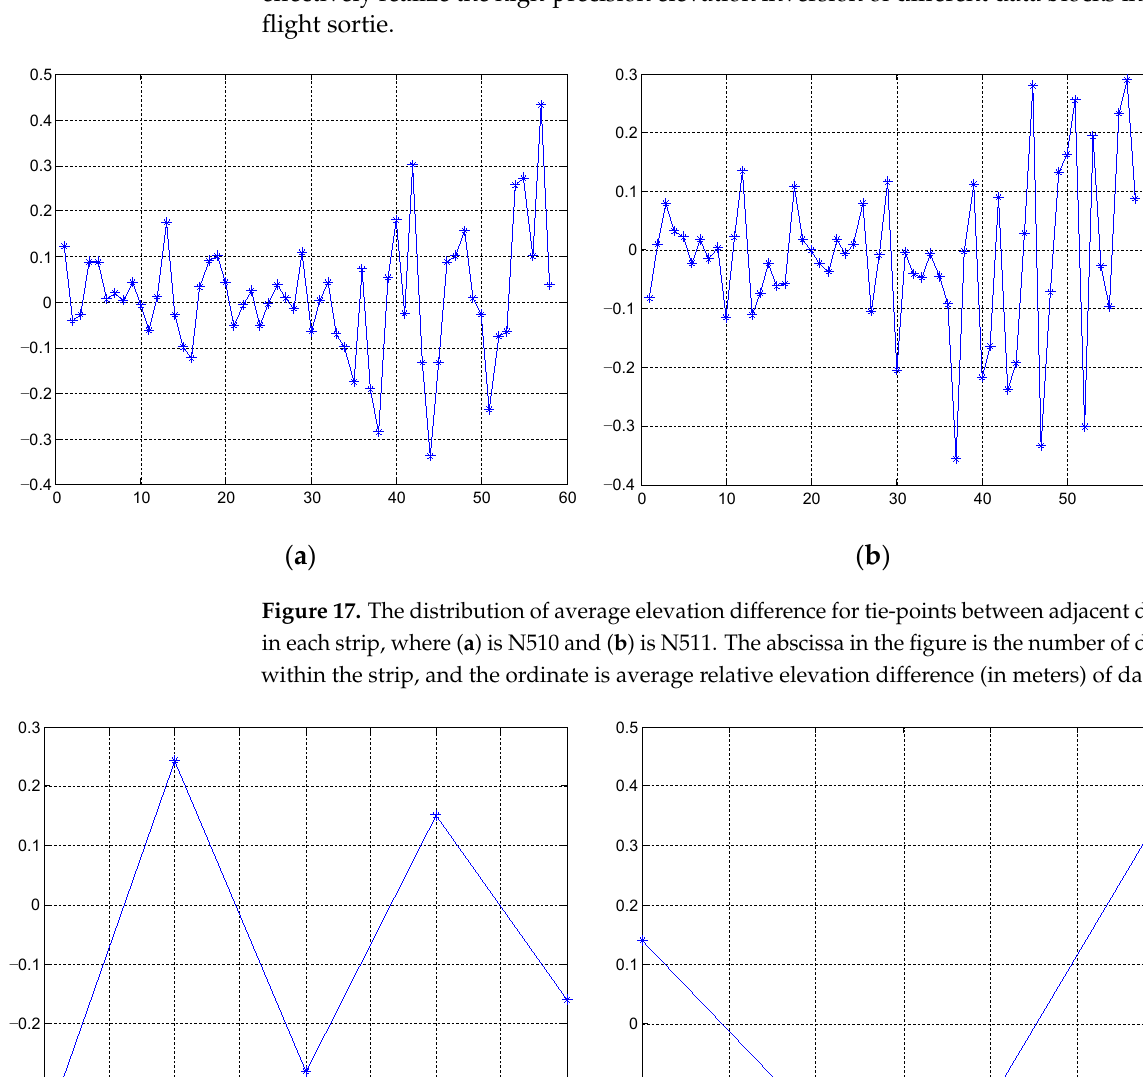
high accuracy requirements of large-scale mapping. This shows that the interferometric